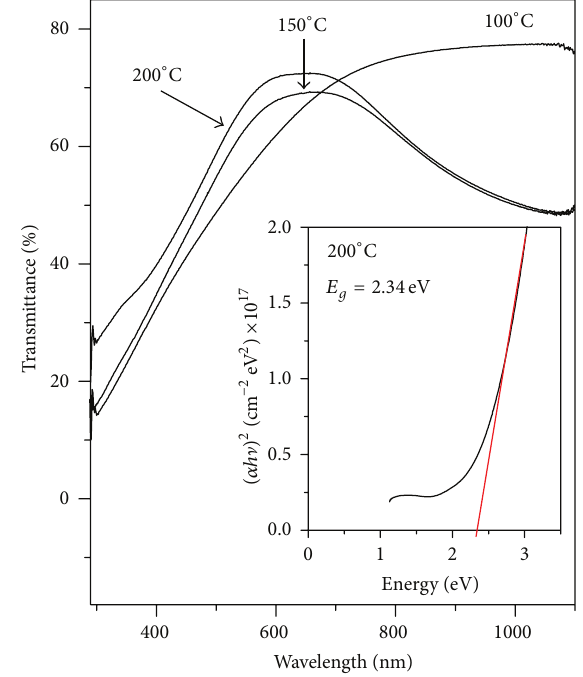
Figure 7: Optical transmittance spectra of CuS thin films annealed in a vacuum atmosphere. Inset plot of the ( 𝛼ℎ ] ) 2 versus ℎ ] for CuS thin film with 𝑇 𝑎 = 200 ∘